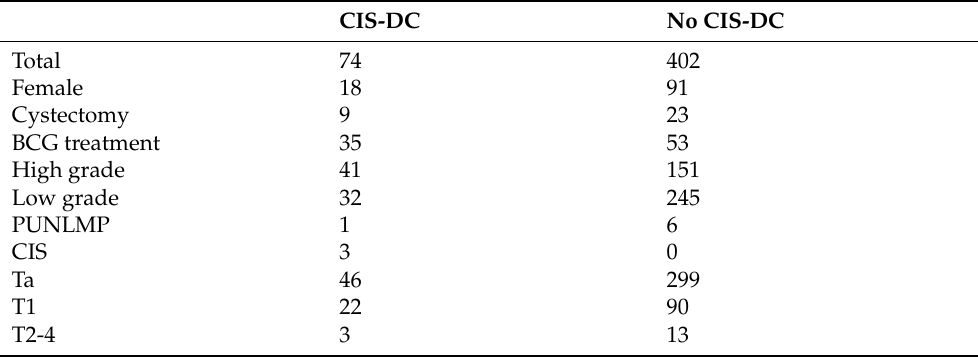
Table A2. Dataset characteristics per CIS in disease course (CIS-DC; yes/no).